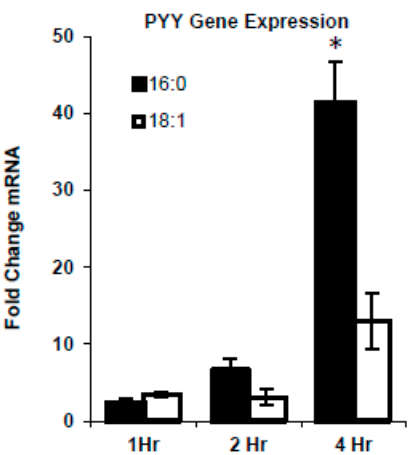
Figure 1. MUFA vs. SFA induced PYY response in vitro. STC-1 cells were treated with vehicle (EtOH), MUFA (18:1), or SFA (16:0), and PYY mRNA levels were measured by qPCR. Both SFA and MUFA increased PYY level in L-cells in a time-dependent manner. However, SFA treatment induced a higher level of PYY than MUFA. Data are represented as mean ± SEM; * p < 0.05 vs. 18:1.